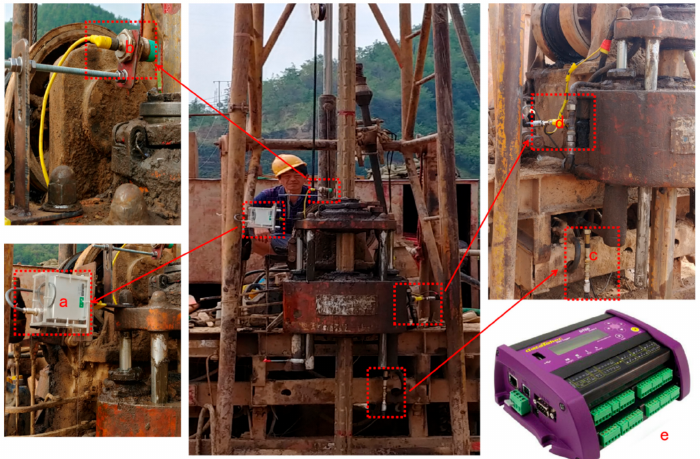
Figure 4. DPM sensors non-destructively installed on the drilling rig: ( a ) displacement sensor ( b ) rotation sensor ( c ) oil inlet pipe oil pressure sensor ( d ) oil outlet pipe oil pressure sensor ( e ) data acquisition